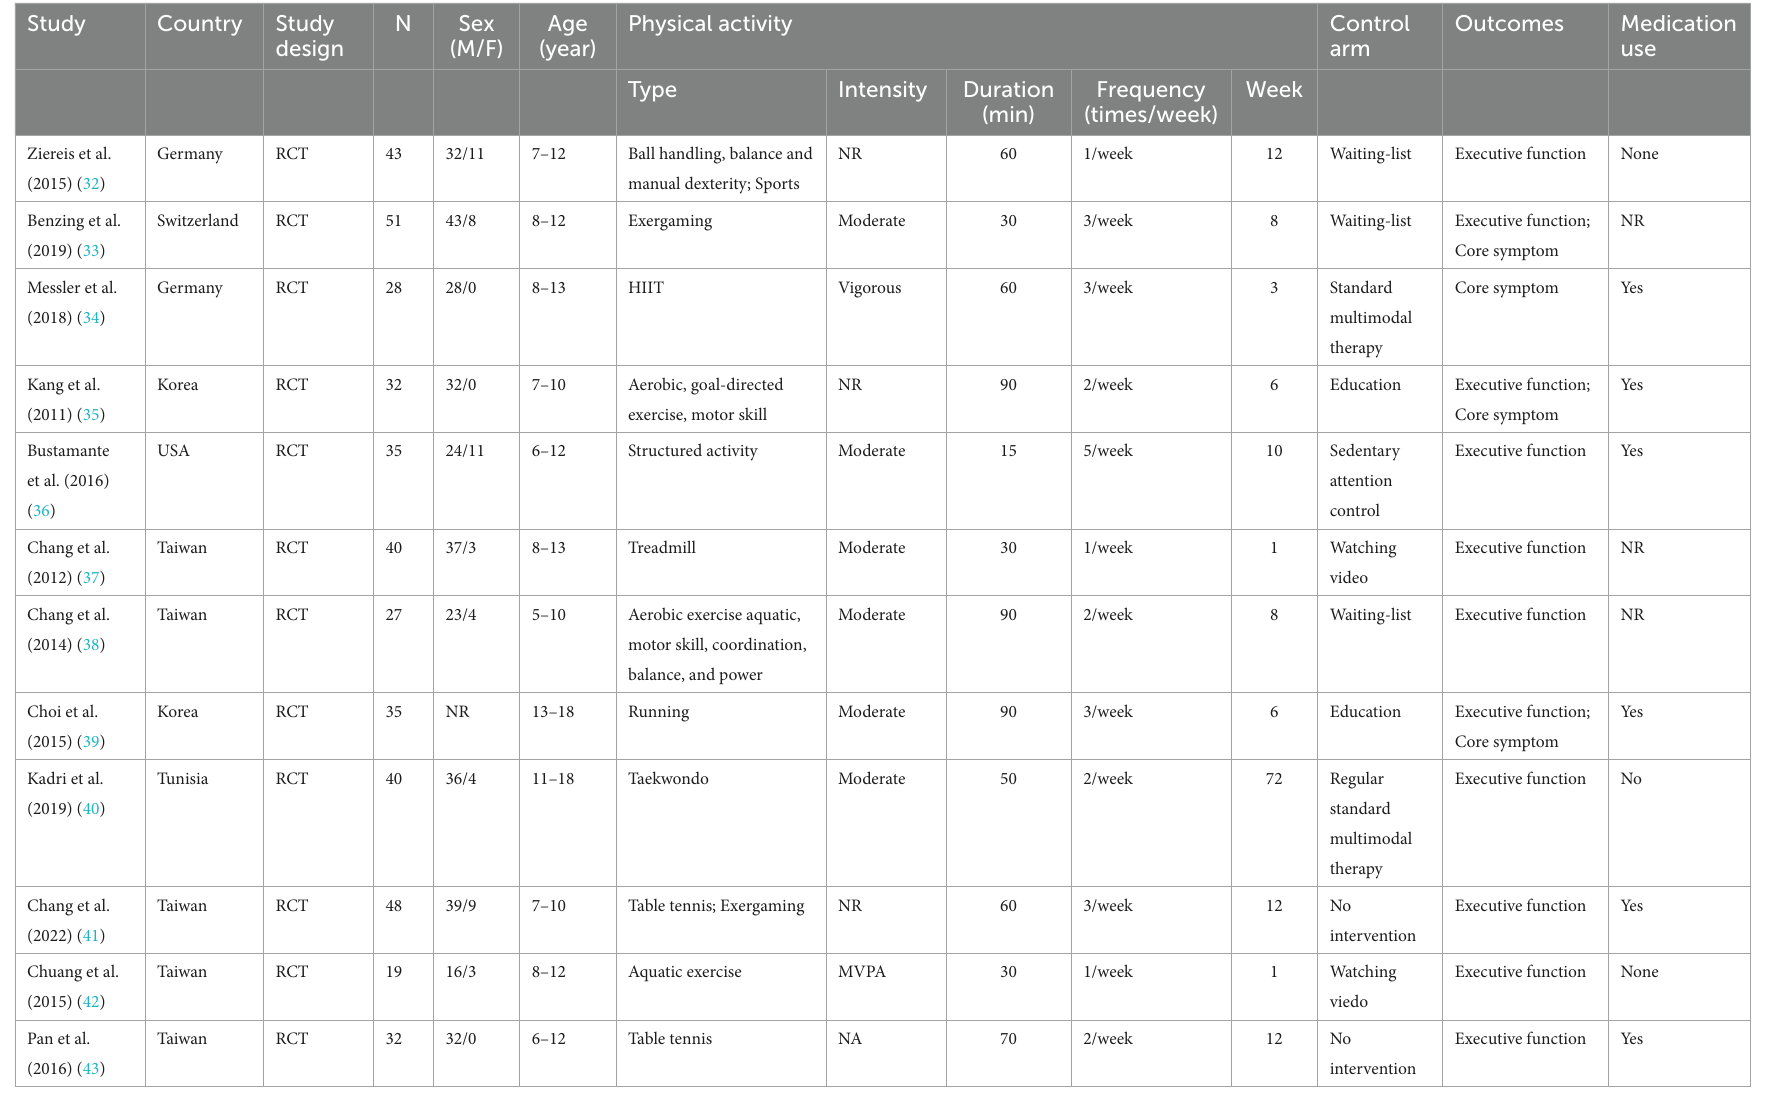
TABLE 1 Characteristics of studies included in the